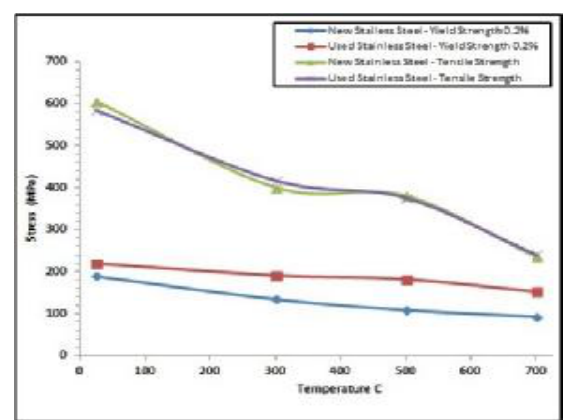
Fig. 7. Stress-strain curve under different temperatures for ex-used stainless steel 321H.